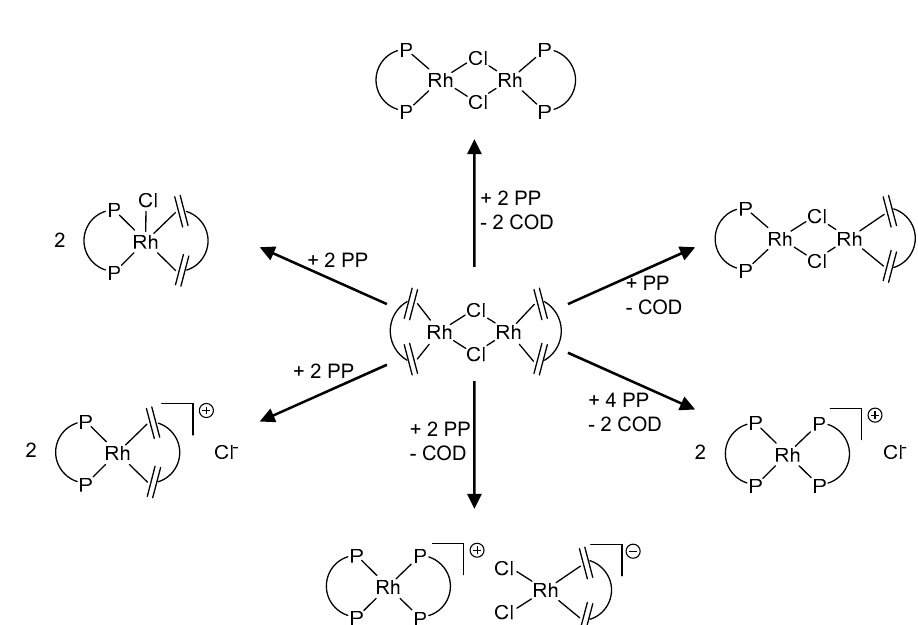
Scheme 1: In situ generation of rhodium/diphosphine complexes—known range of species which can be formed during the in situ reaction of rhodium diolefin precursors with diphosphine ligands.